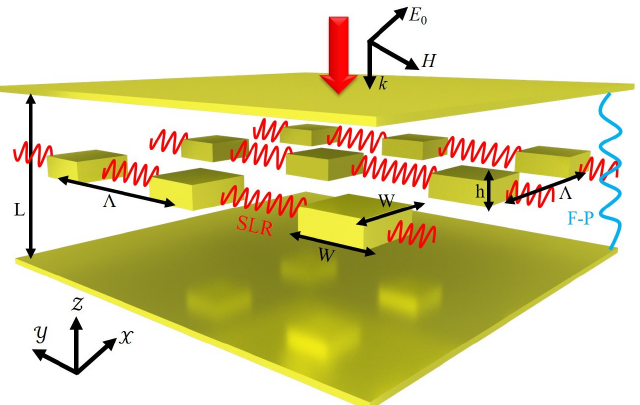
Figure 1. Schematic of the strong coupling between the F-P and the SLR resonance when metal nanorods are positioned within an F-P cavity formed by two gold mirrors.